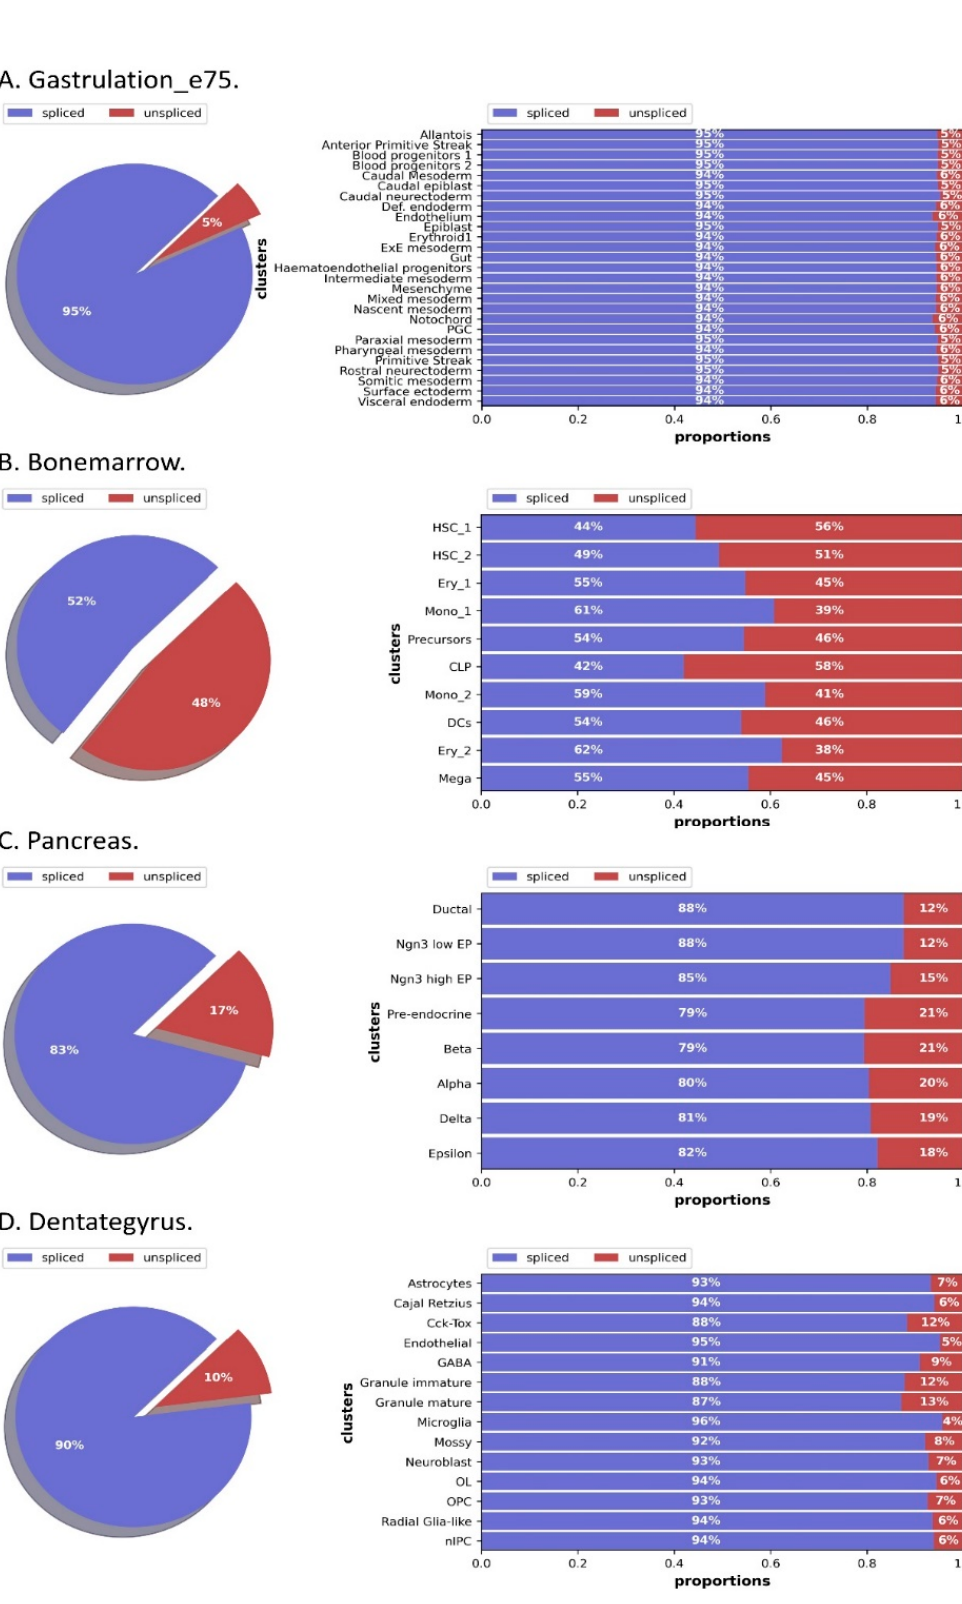
Figure 1. The distribution of spliced to unspliced proportions of cell types in different datasets.